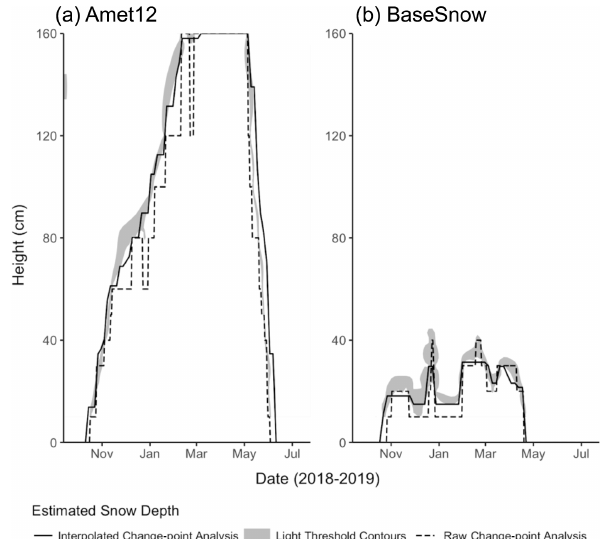
Figure 8. Comparison of snow depths derived with light-based methods for (a) a forested site (Amet12) and (b) a shrub-tundra site (BaseSnow). Snow depth estimates are provided for raw change- point analysis (dashed lines), interpolated change-point analysis (black line), and interpolated contours using minimum and maxi- mum snow cover thresholds (grey